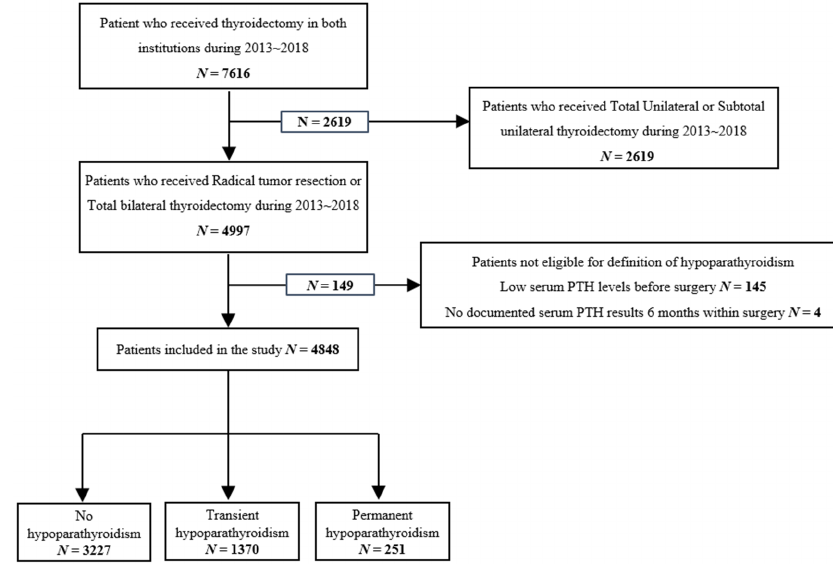
Figure 1. Flowchart of patient inclusion. Table 1. Baseline Characteristics.